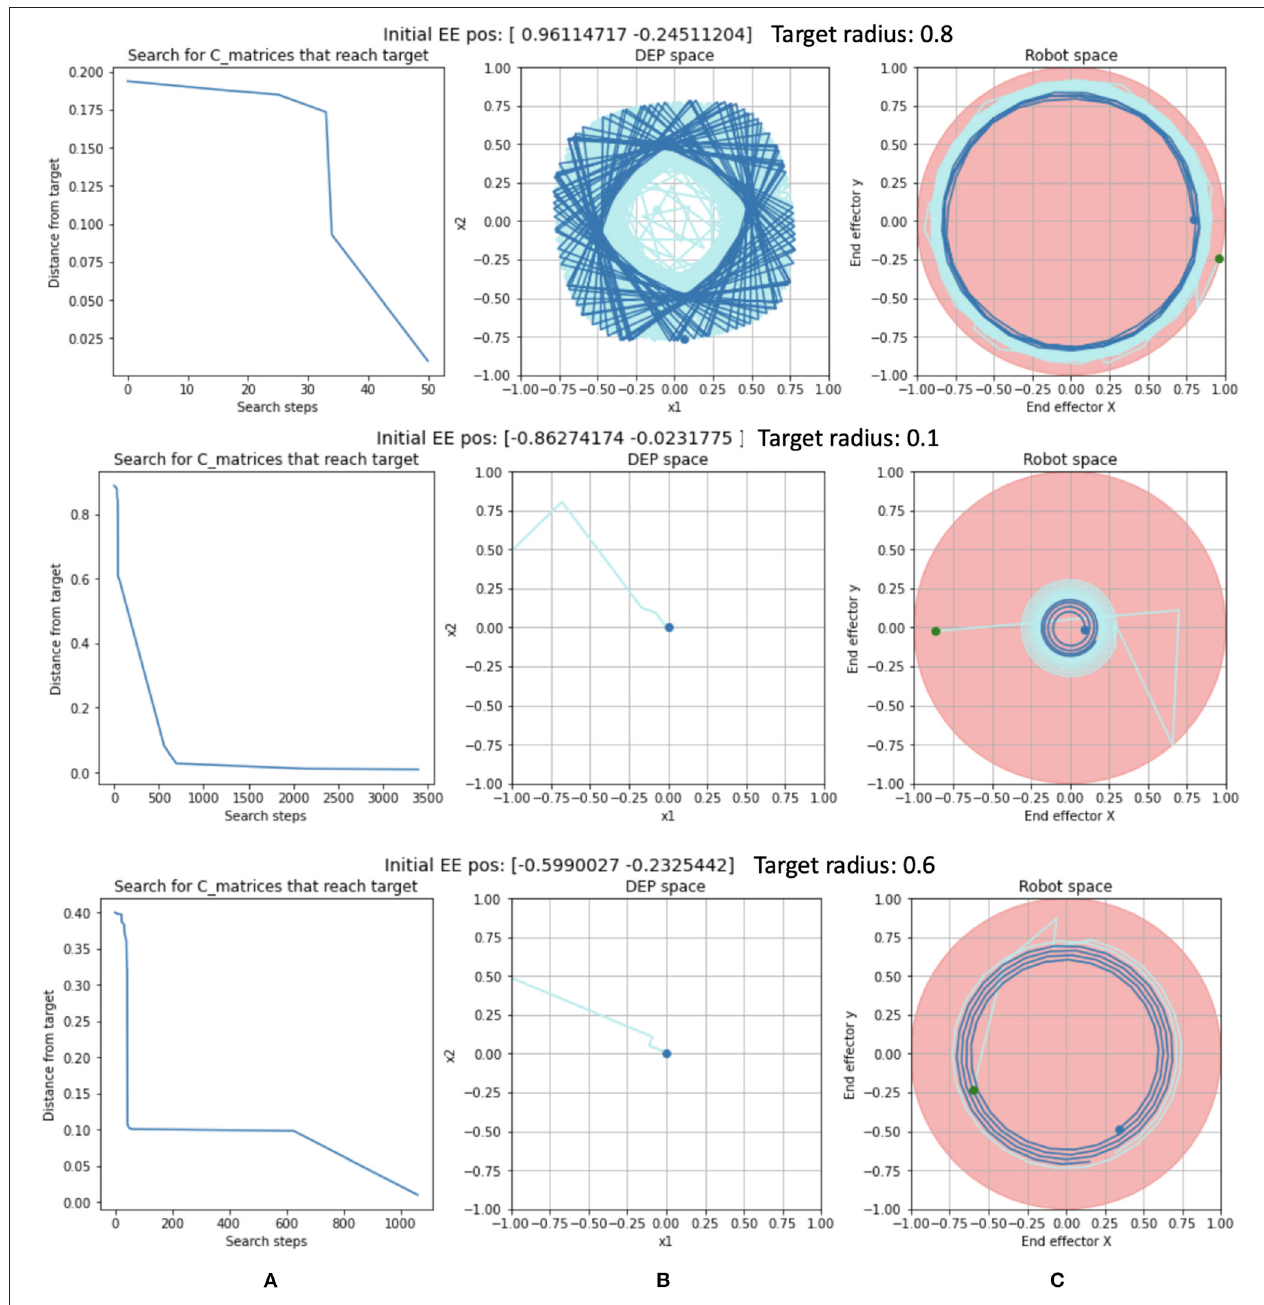
FIGURE 6 | Examples of Circular Trajectory trials with: (A) The progress of the search for a solution C matrix. (B) The solution trajectory in DEP space. (C) The solution trajectory in robot space. The most recent positions are shown in dark blue while the early part of the trajectory is in light